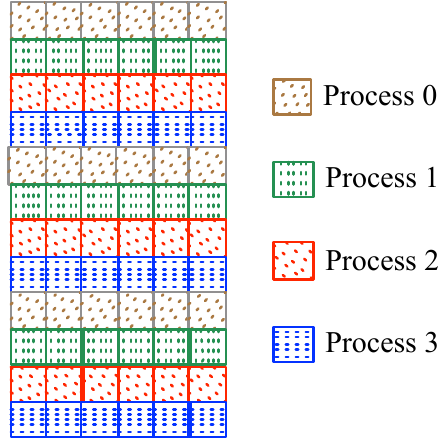
Figure 6. Task distribution scheme where each row represents a similarity